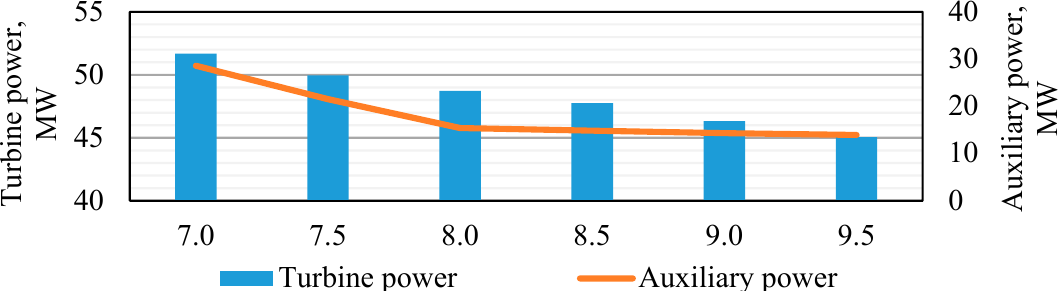
Figure 5. Dependence of the useful efficiency of the cycle on the power of the turbine and the power of auxiliary needs at the pressure at the change outlet of the carbon dioxide turbine in the cycle with the base set.